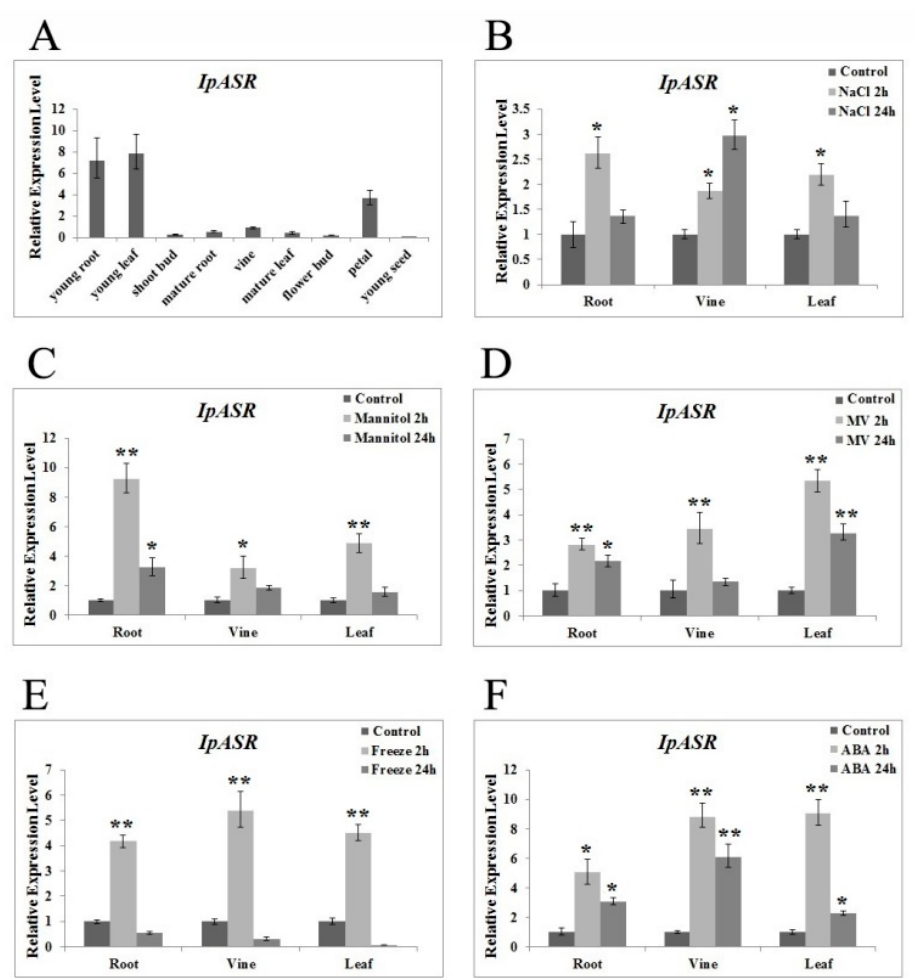
Figure 3. Expression profiles of the IpASR gene among the I. pes-caprae tissues. ( A ) Differential expression of IpASR in various tissues (young root, young leaf, shoot bud, mature root, vine, mature leaf, flower bud, petal, and young seed). Time-course expression patterns of IpASR in response to different abiotic stresses: NaCl ( B ) mannitol simulating dehydration ( C ) MV (methyl viologen), ( D ) freezing, ( E ) and abscisic acid (ABA) treatment. ( F ) Values are the means ± standard deviation (SD) ( n = 3). Asterisks indicate significant differences from the control (Student’s t -test p values, * p < 0.05 and ** p < 0.01).